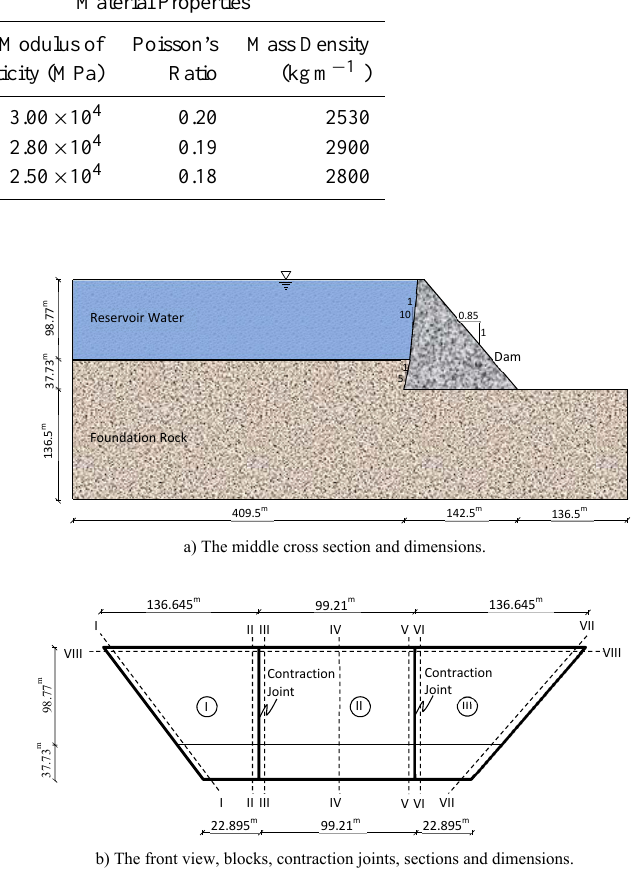
Fig. 8. The views and dimensions of the Çine RCC dam (DSI, 2012).